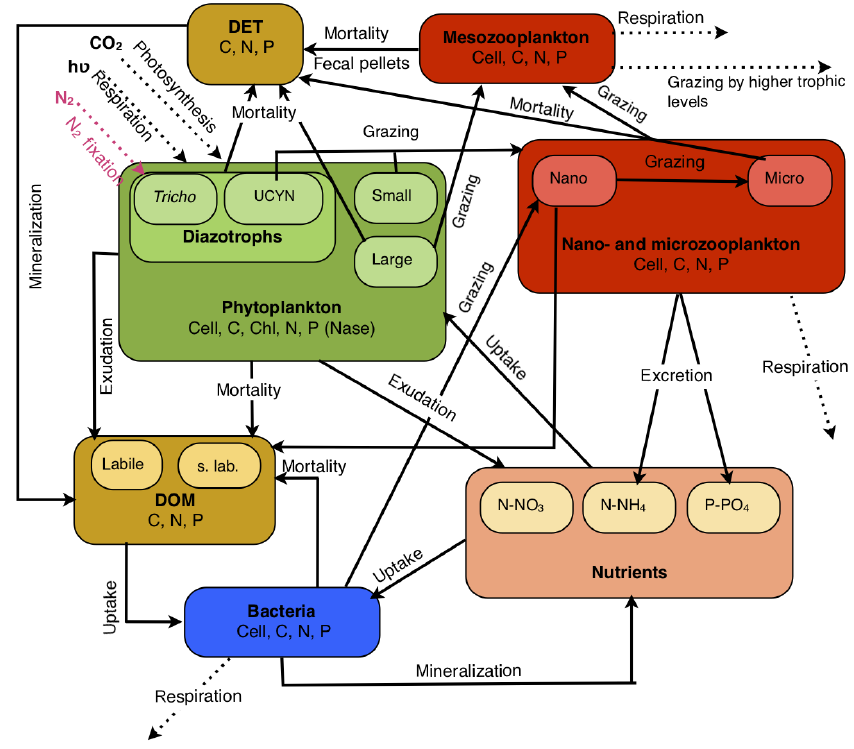
Figure 1. Conceptual diagram of the biogeochemical model (Eco3M-Med enhanced with diazotrophs) from the 1 DV coupled physical– biogeochemical used for the OUTPACE project.